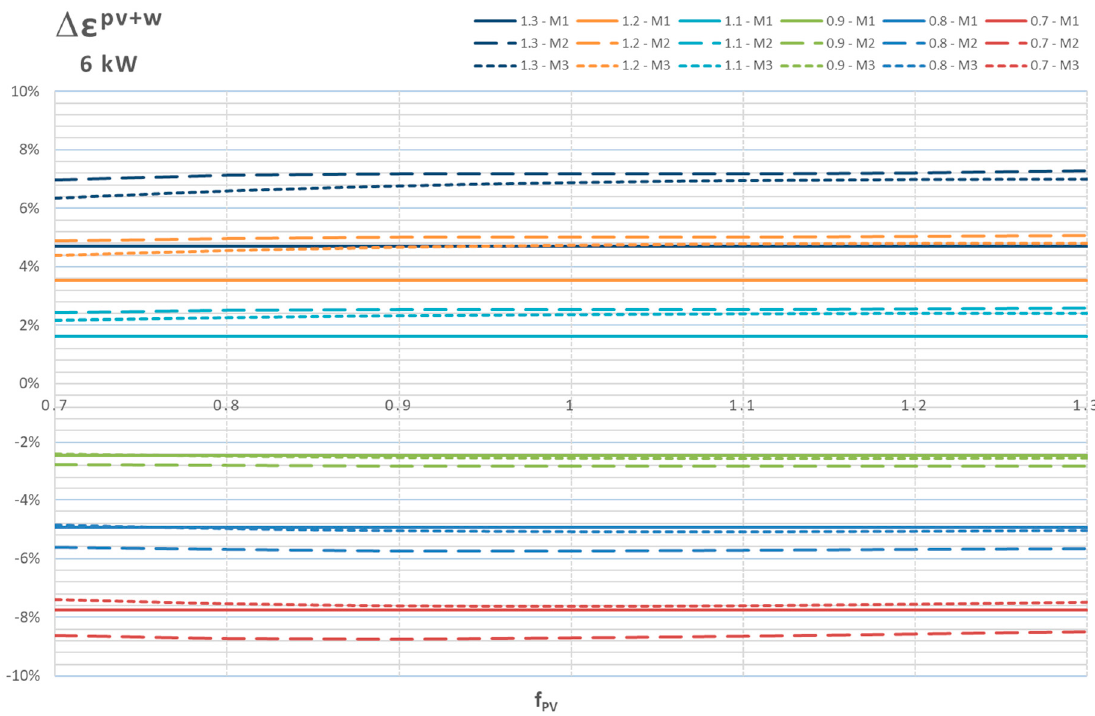
Figure 18. Variation of ε PV + W with the multiplication factors f pv and f w . in a 6 kW power capacity facility (M1, M2 and M3 represent the results obtained by means of application of the normalisation methods 1, 2 and 3, respectively).